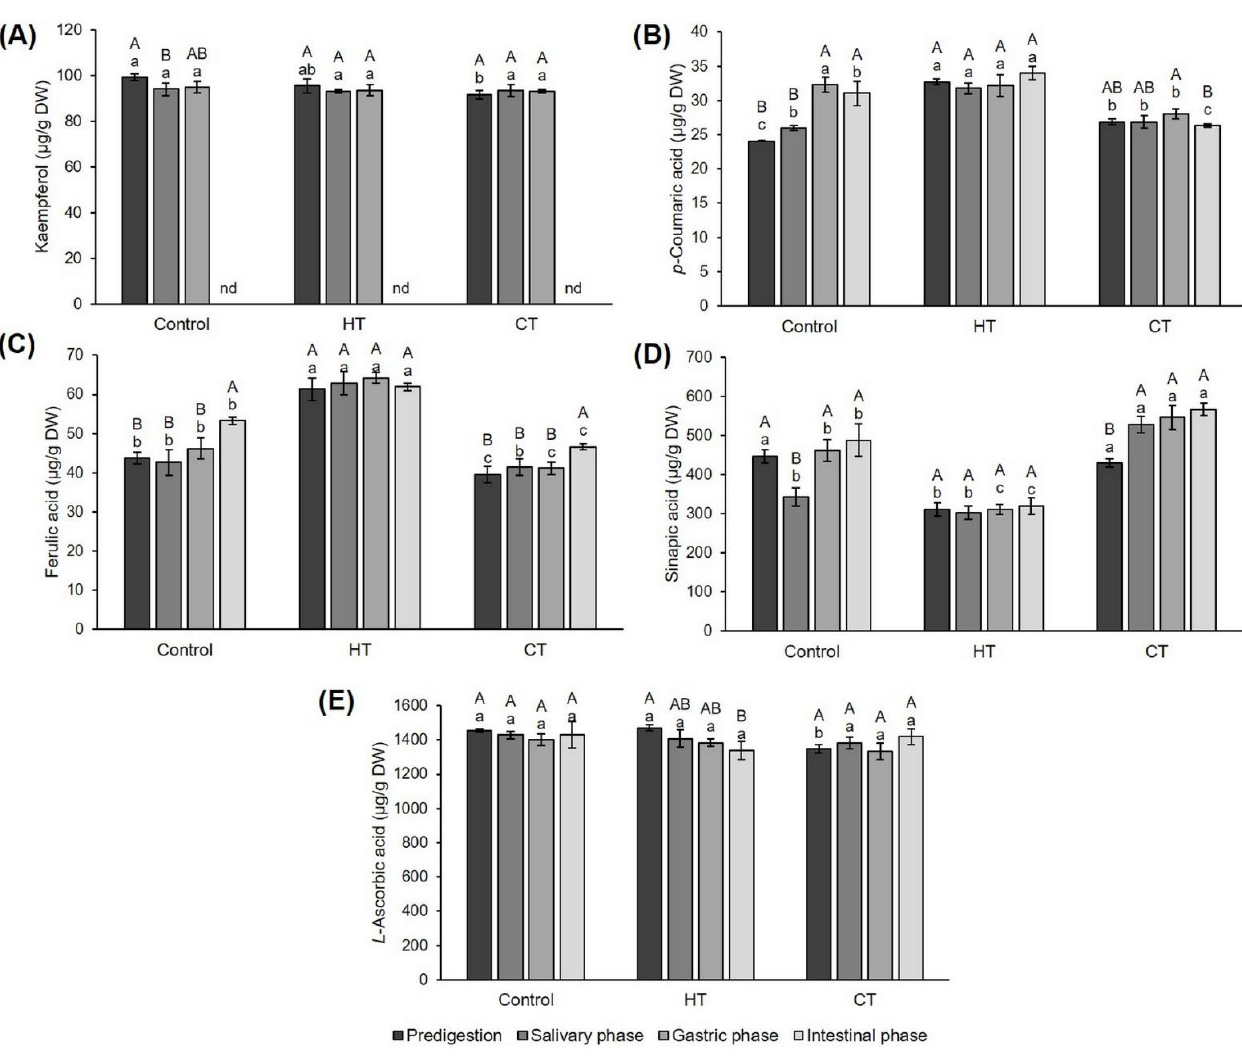
Figure 1. Effects of hot- and cold-water stress on the concentration of individual phenolic compounds: ( A ) kaempferol, ( B ) p- coumaric acid, ( C ) ferulic acid, ( D ) sinapic acid and ( E ) vitamin C from broccoli during in vitro simulated human digestion. The results are expressed in μg/g of dry weight. Values represent mean ± standard deviation of three biological replicates. Different capital letters indicate a significant difference among the values of digestion phases for one sample, and different small letters indicate a significant difference among the values of three samples in one digestion phase (ANOVA, Duncan test, p ≤ 0.05). Con = plants watered with room-temperature water, HT = plants watered with high-temperature water, CT = plants watered with cold water.